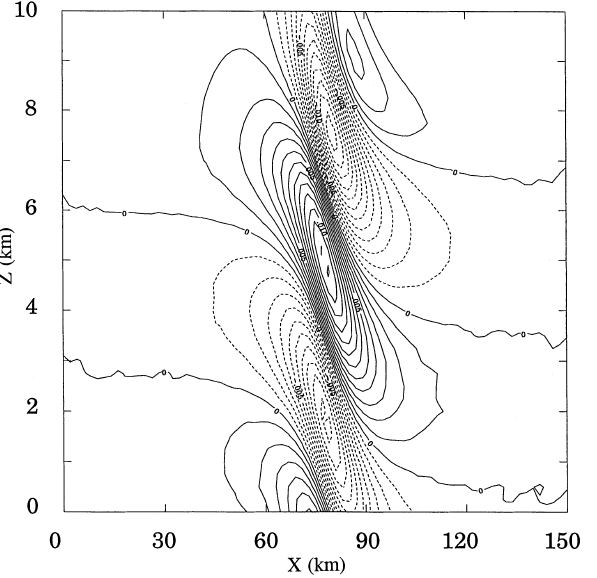
Fig. 11. Field of vertical velocity in the control simulation for 2D linear, non-hydrostatic mountain waves; contour interval is 0 : 01ms (cid:255)